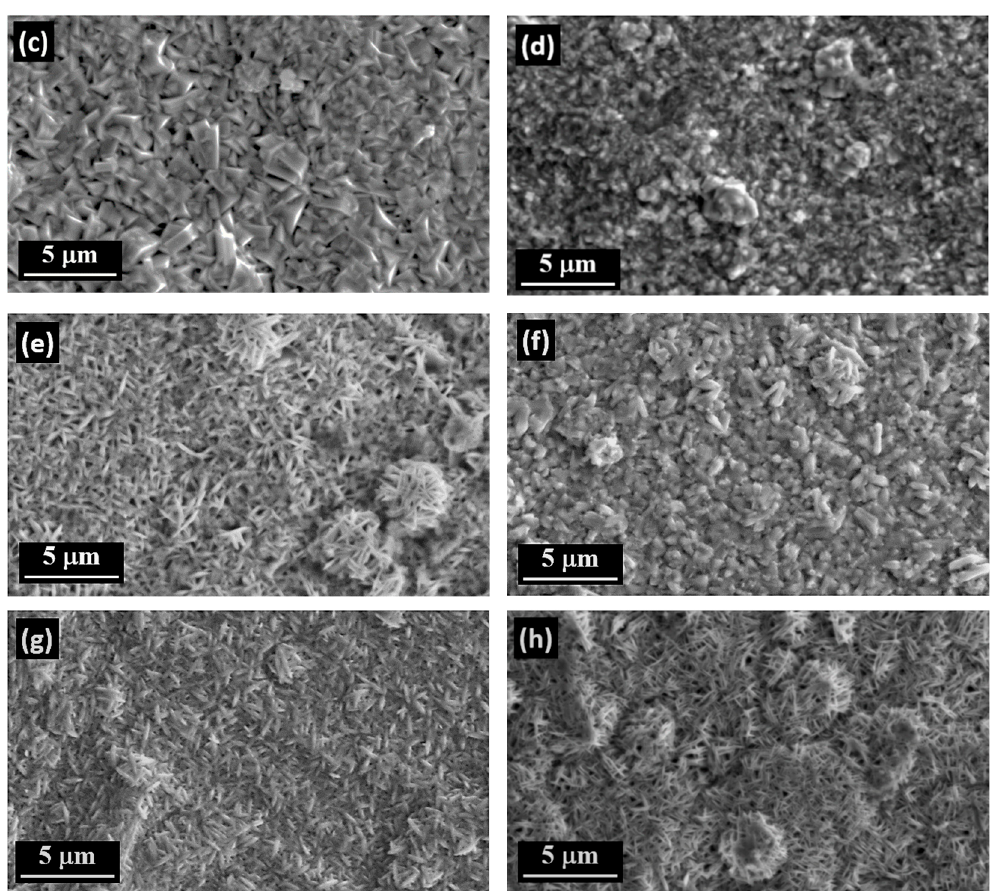
Figure 9. SEM SE images of surfaces of Zn ( a ) and Zn–SiC ( b – h ) layers formed by PED at j avg = − 3.0 A·dm − 2 , f = 50 Hz, θ = 0.5, with ( c – h ) or without ( a , b ) surfactants. ( c ) SDS, ( d ) gum arabic, ( e ) gelatin, ( f ) CTAB, ( g ) PEG 20000, ( h ) Triton X–100.